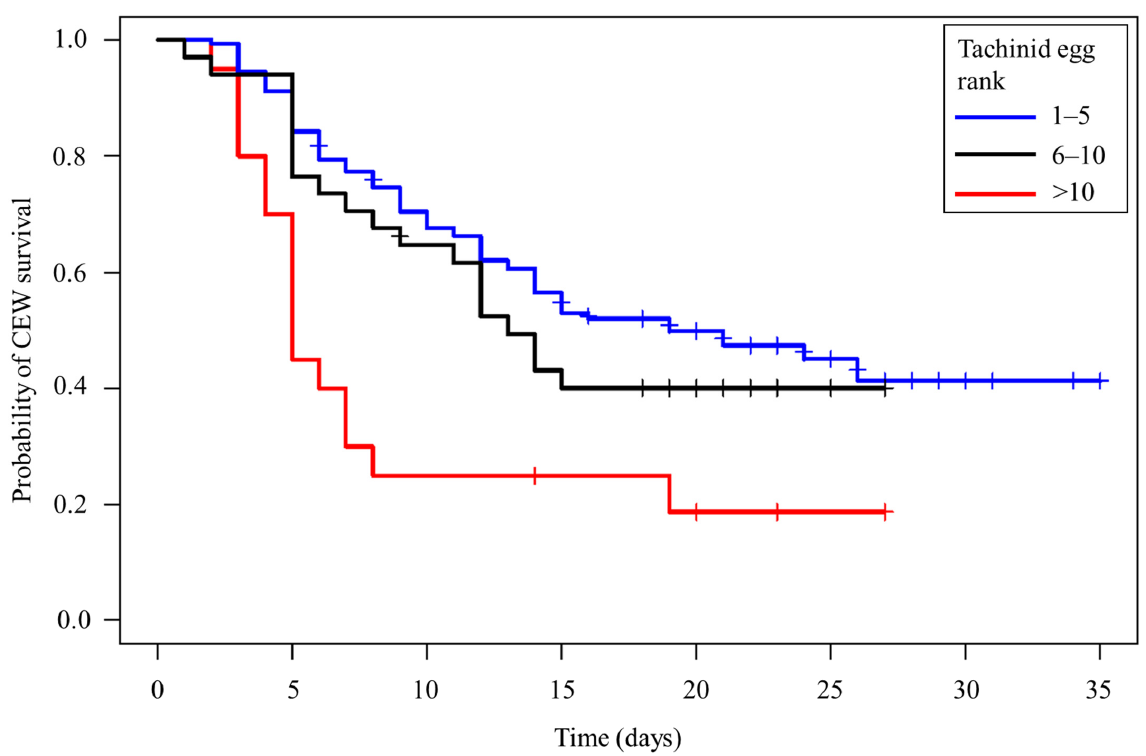
Figure 8. Kaplan–Meier curves of CEW larval survival relative to egg rank category. Perpendicular lines indicate censored individuals.